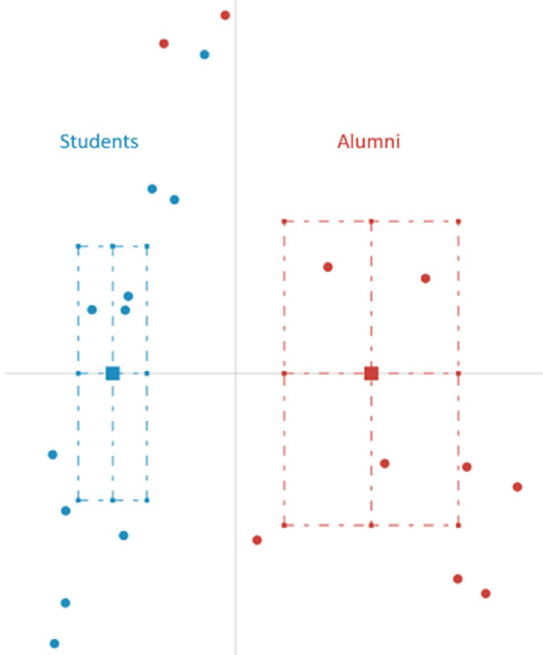
Fig. 2 Confidence intervals around network means (square) for participant units